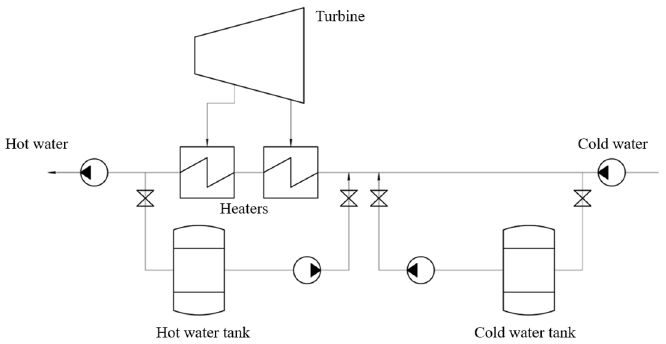
Figure 12. Heat flow chart of TPP with heating water accumulator.